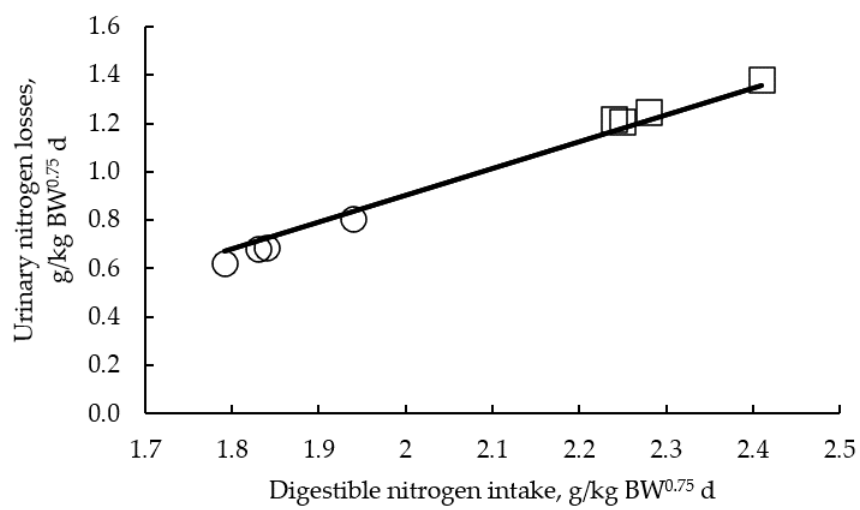
Figure 1. Relationship between digestible nitrogen intake and urinary nitrogen losses during fattening in rabbits (Urinary nitrogen losses = − 1.31( ± 0.13) + 1.11( ± 0.061) digestible nitrogen intake; N = 8; p < 0.001. Original observations plotted with the mean regression line across studies: Ο Delgado et al., 2018 . □ Current study).